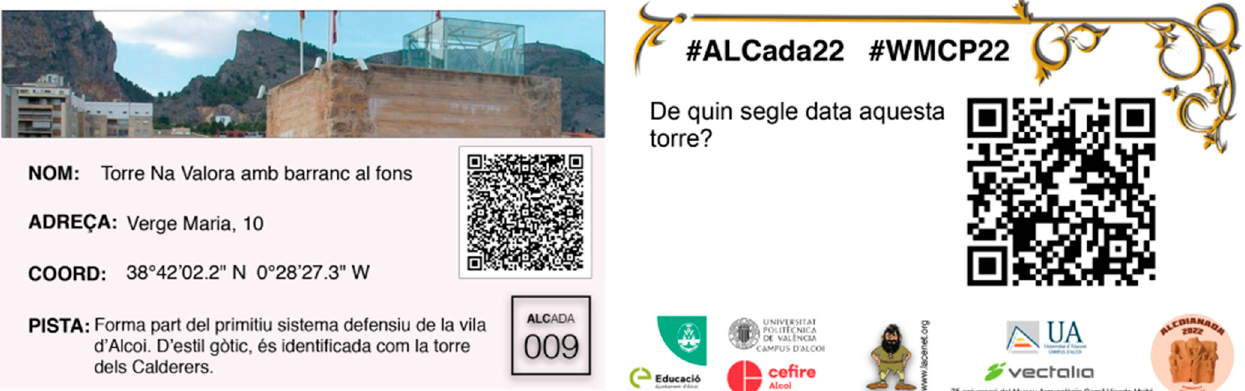
Figure 1. Example of the front and back of a card of one of the points of interest. Notes: Name: Na Valora tower with ravine in the background; Address: 10 Verge Maria street; Coordinates: 38°42 ′ 02.2 ′′ N—0°28 ′ 27.3 ′′ W; Clue: It is part of the primitive defensive system of the town of Alcoy.